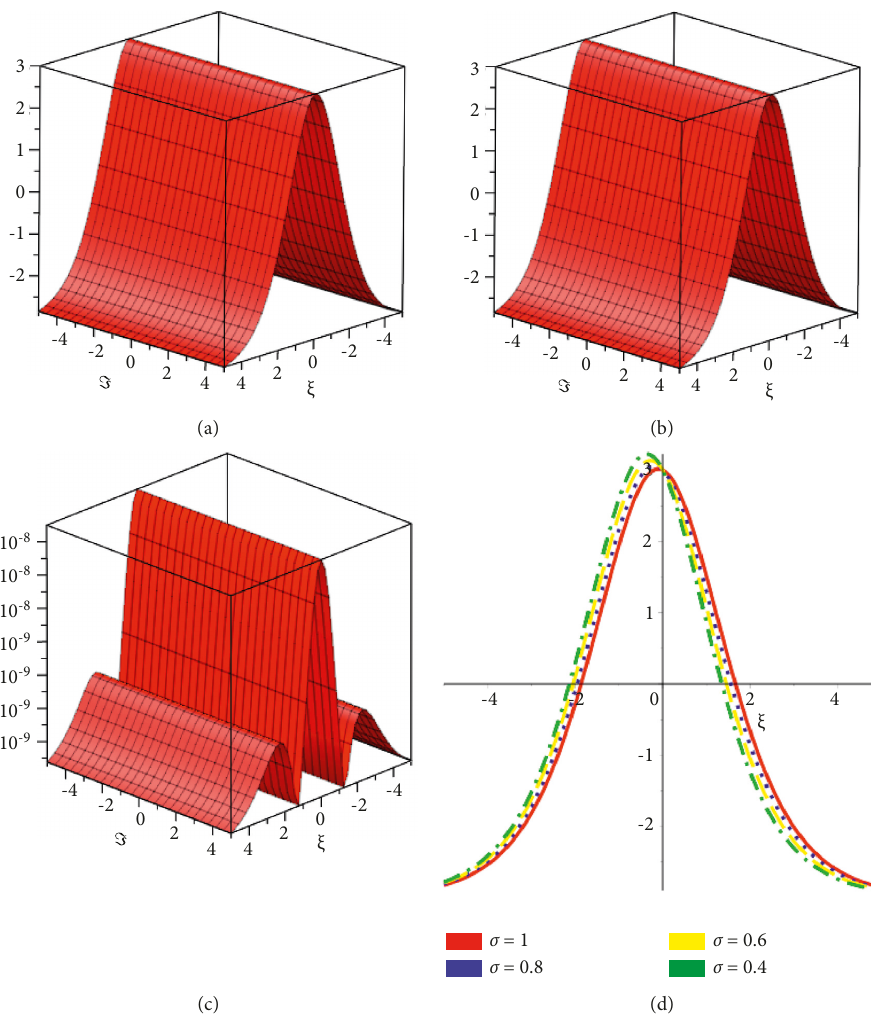
Figure 1: Exact solution, analytical solution, absolute error, and various fractional order solution for φ ( ξ , I ) of problem 1.